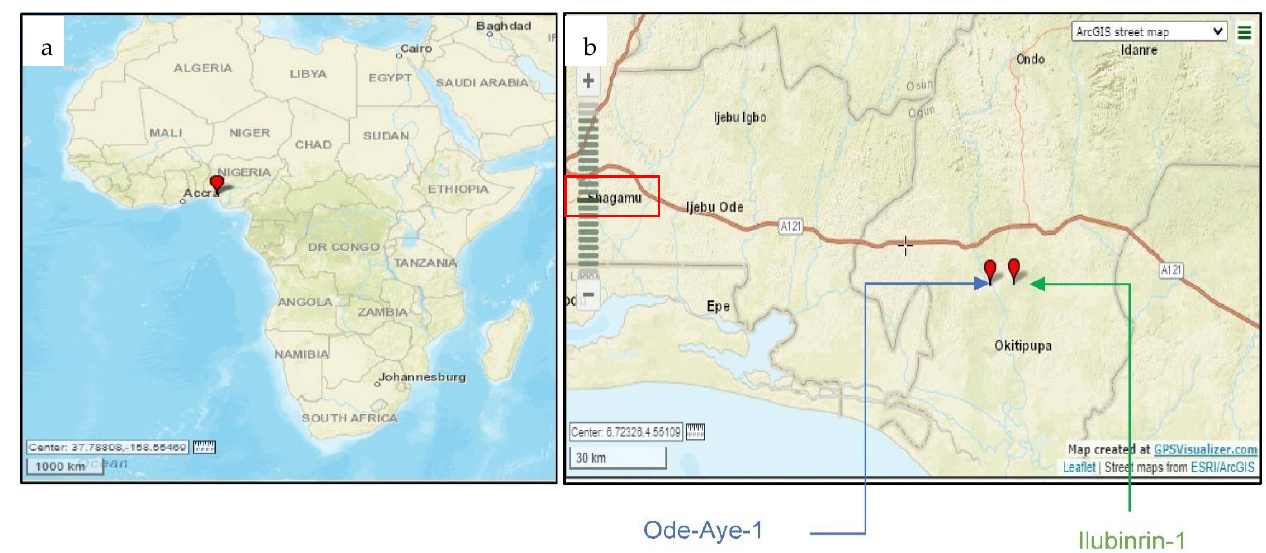
Figure 1. Maps showing the area of study. ( a ) Map of Africa showing the field of study in Nigeria. ( b ) Regional map of a part of southwestern Nigeria, indicating the well locations. The Ode-Aye-1 well is located at latitude 06° 38 ′ 10.2 ′′ N and longitude 004° 45 ′ 59.7 ′′ E. In contrast, Ilubinrin-1 is located at latitude 06° 38 ′ 19.8 ′′ N and longitude 004° 49 ′ 47.9 ′′ N. The maps were generated using G.P.S. Visualizer (G.P.S. Visualizer).